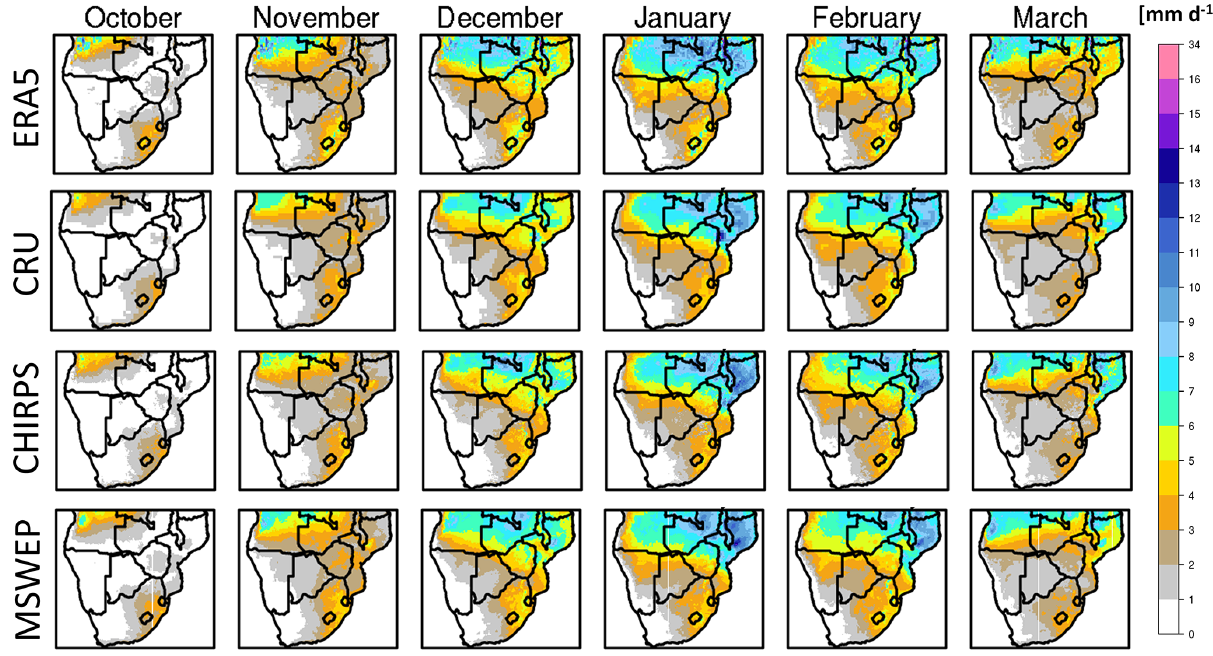
Figure 1. Monthly mean precipitation climatology for the period 1985–2005. Table 1. Gauge-based, satellite, reanalysis, and merged precipitation products analysed over the study region using monthly mean precipita- tion for the period 1985–2005.